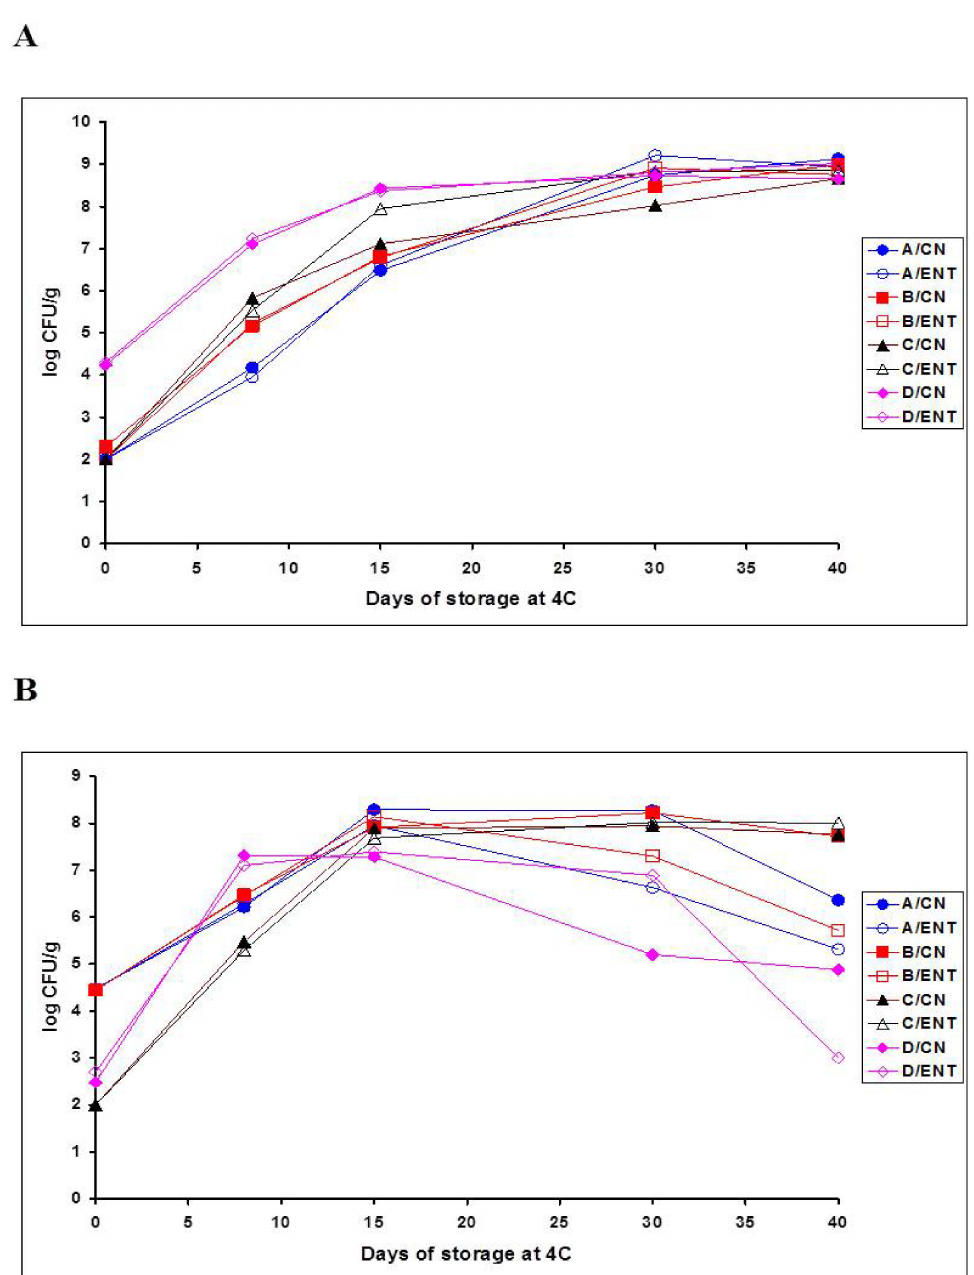
Figure 2. Cheese batch-dependent growth (log 10 CFU/g) of spoilage lactic acid bacteria, enumerated on MRS agar at 30 ◦ C ( A ), and spoilage Pseudomonas -like bacteria, enumerated on CFC agar at 25 ◦ C ( B ), during refrigerated (4 ◦ C), vacuum-packed storage of four batches (A, B, C and D) of fresh Greek Anthotyros whey cheeses without (CN) or with 5% (v/w ) of an added crude enterocin A-B-P extract